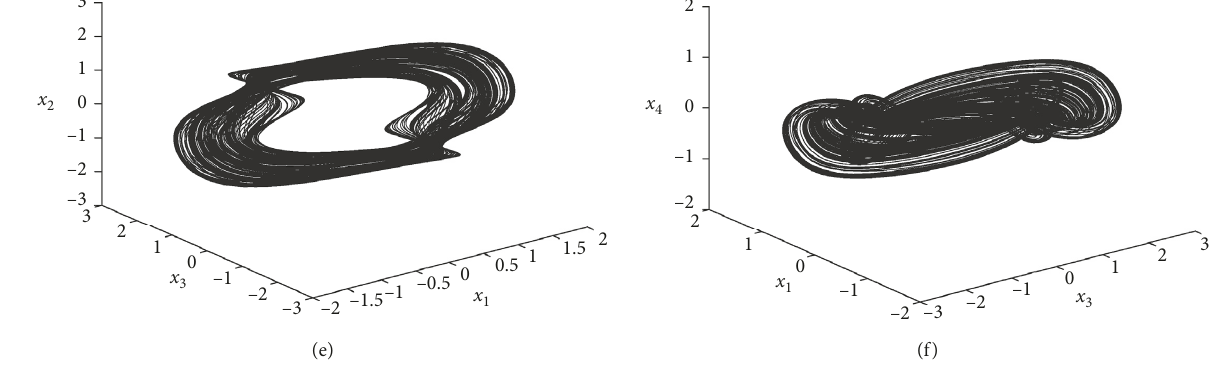
Figure 13: Chaotic motion exists when b